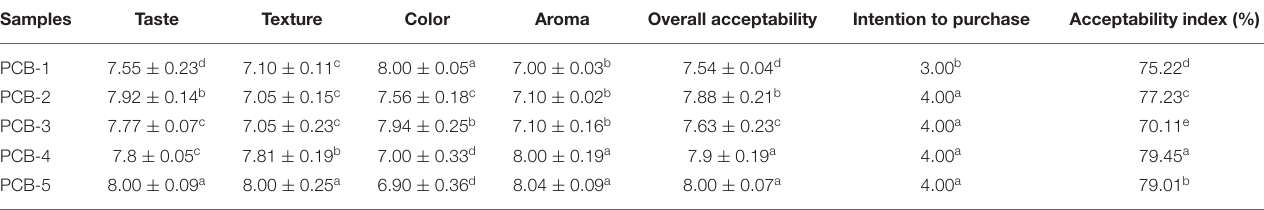
TABLE 6 | Sensory and average acceptance of PCB. Samples